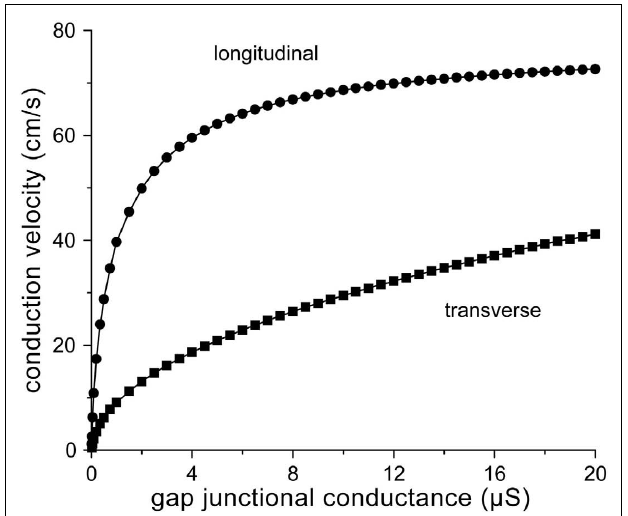
FIGURE 2 | Relation between conduction velocity and gap junctional conductance for the strands of Figure 1.